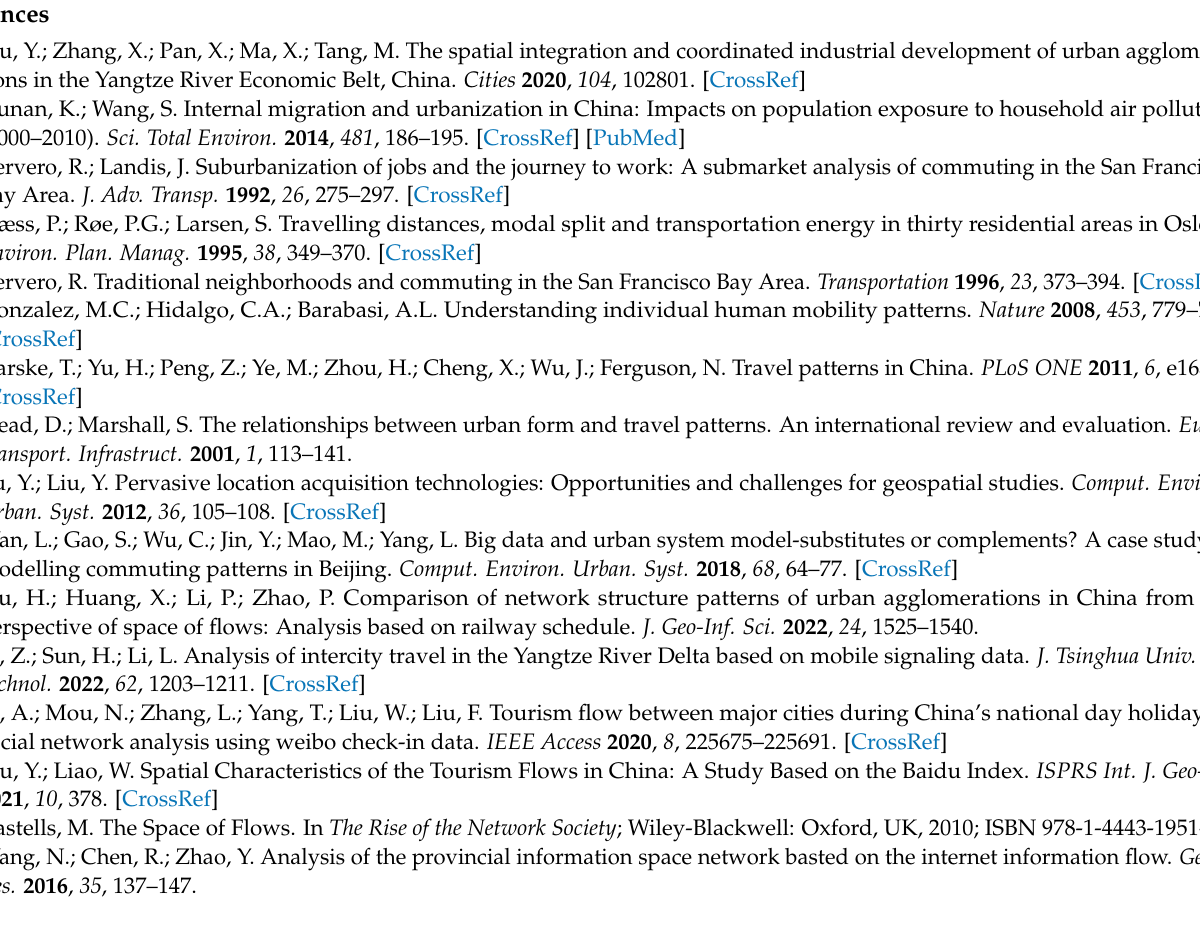
Figure S3. The intercity mobility patterns in the GBA when k = 2. ( a ) Spatial flow of intercity mobility pattern A. ( b ) Spatial flow of intercity mobility pattern B. ( c ) Temporal flow of intercity mobility pattern A. ( d ) Temporal flow of intercity mobility pattern B; Figure S4. The intercity mobility patterns in the GBA when k = 3. ( a ) Spatial flow of intercity mobility pattern A. ( b ) Spatial flow of intercity mobility pattern B. ( c ) Spatial flow of intercity mobility pattern C. ( d ) Temporal flow of intercity mobility pattern A. ( e ) Temporal flow of intercity mobility pattern B. ( f ) Temporal flow of intercity mobility pattern